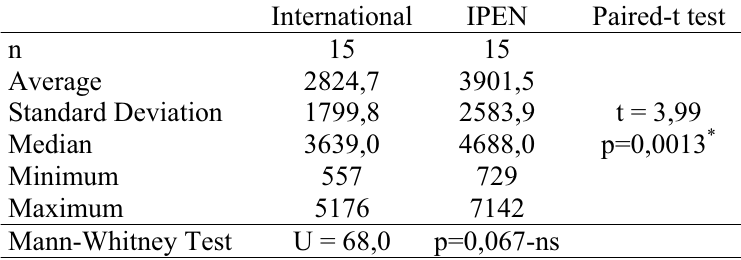
TABLE 3 – Comparison between the values of radiation reading in the injection area using the International and the IPEN intraoperatory gamma detection equipment